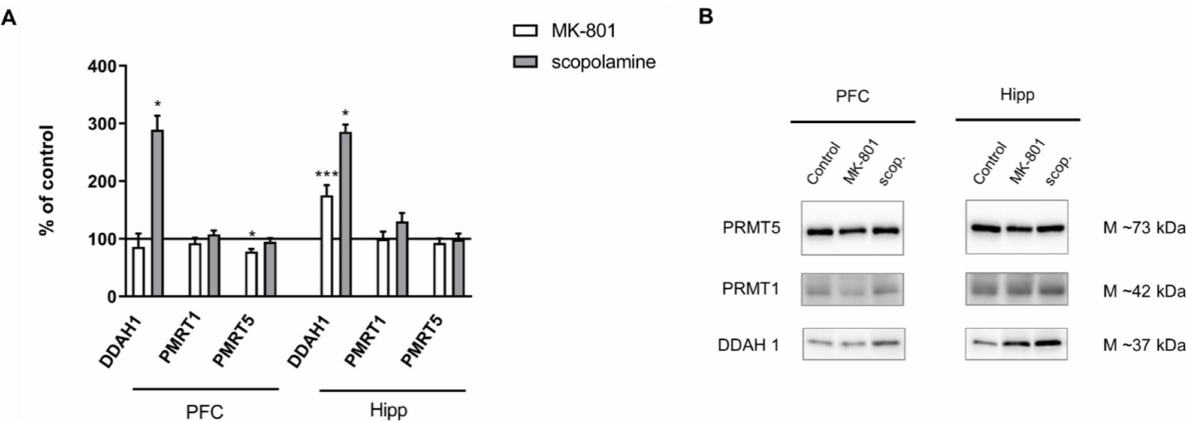
Figure 13. DDAH1, PMRT1 and PMRT5 expression in the prefrontal cortex (PFC) and hippocampus (Hipp) after chronic (14 days) administration of MK-801 (0.3 mg/kg) or scopolamine (1 mg/kg) ( A ). Representative Western blots ( B ). Data are presented as means ± SEM. * p < 0.05; *** p < 0.001 vs.